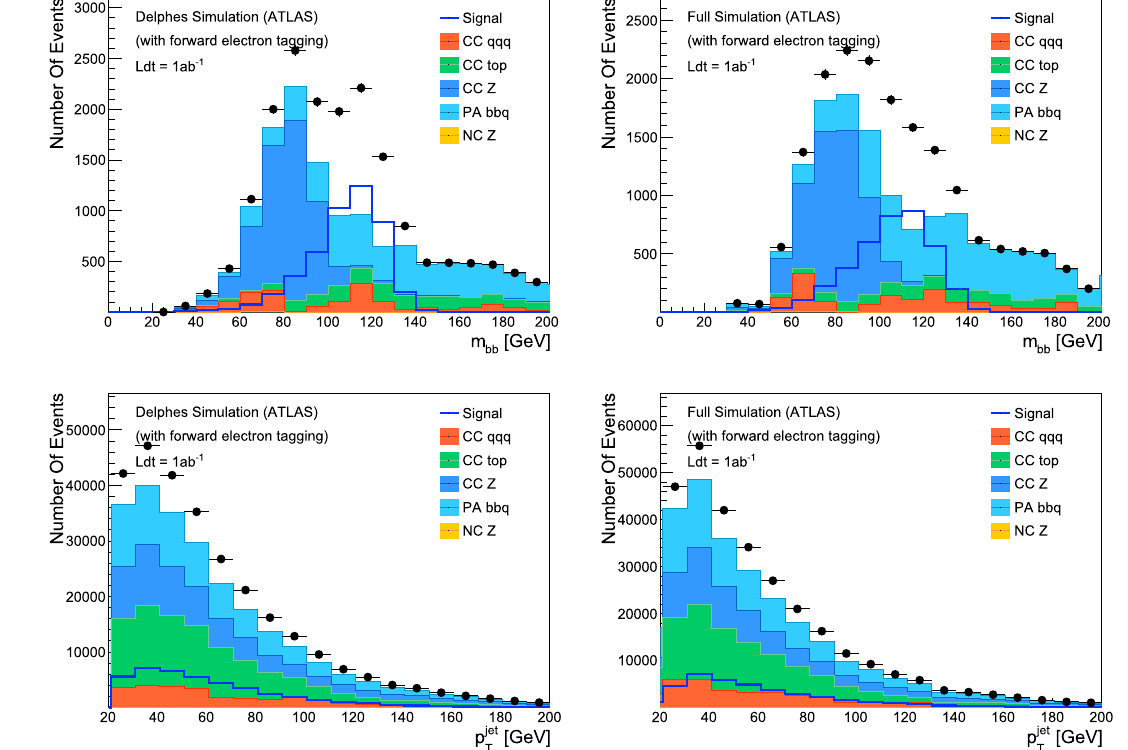
Fig. 4 Invariant di-jet mass distributions of two selected b -tagged jets (upper row) and the p T distribution of all selected jets, i.e. two b -tagged and one light-flavor jet (lower row). In both cases these are performed once using the fast (left) and once the full simulation (right) of the ATLAS